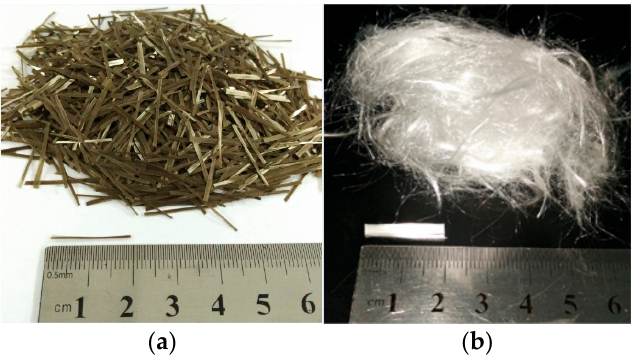
Figure 1. Morphologies of fibres: ( a ) basalt fibre; ( b ) polypropylene fibre.